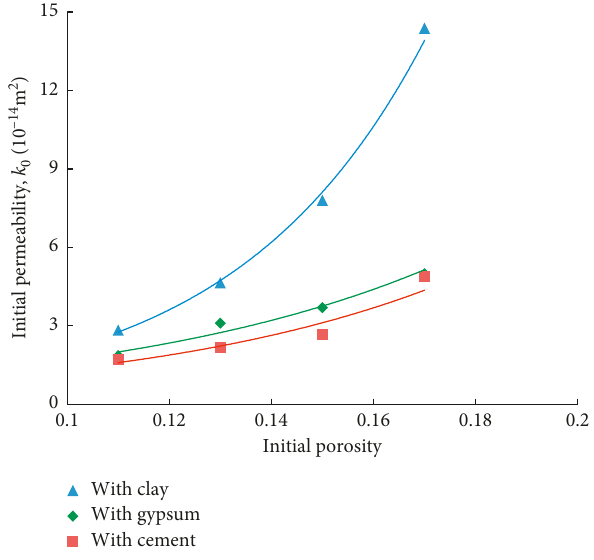
Figure 9: Initial permeability-initial porosity curves.